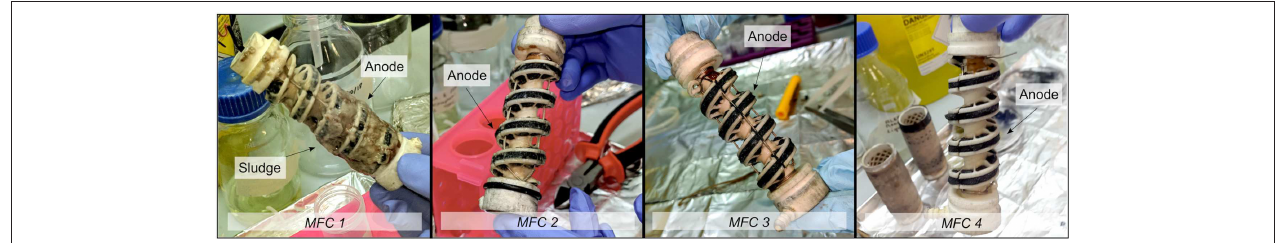
FIGURE 3 | Biomass present through the reactors observed after 115 days operation with synthetic wastewater. An abundant quantity of sludge was found in the anodic compartment of MFC1. Only residues of sludge were present in MFC2. No sludge was observed in MFC3 and MFC4.